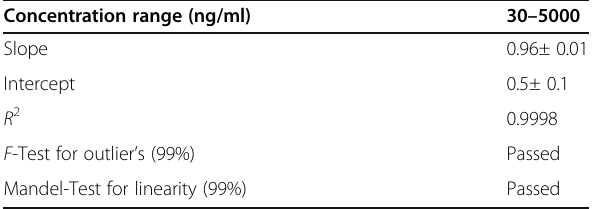
Table 1 Response function for EtG in urine at 99% confidence intervals Concentration range (ng/ml)